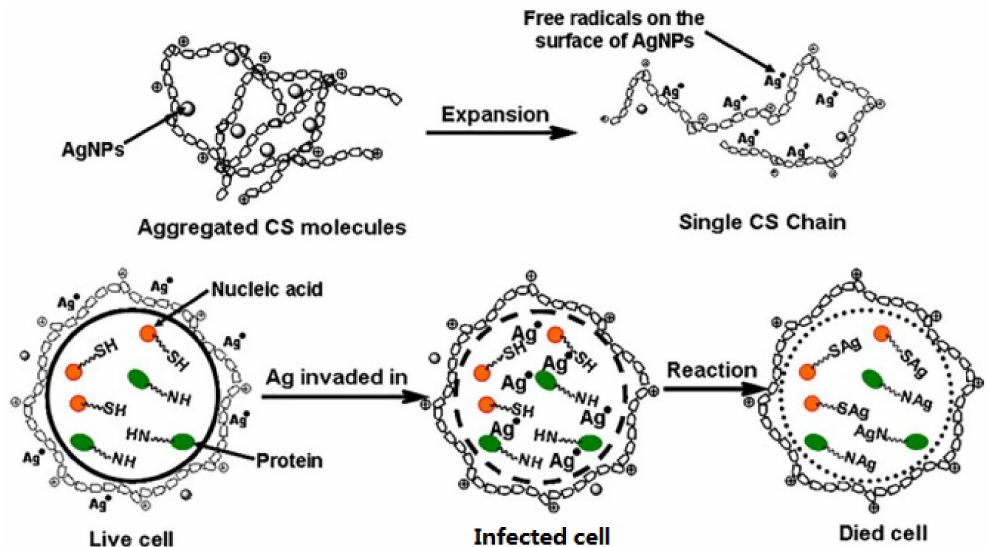
Figure 4. Schematic illustration of inhibition mechanism of AgNP/CS microspheres on microorganisms [22]. Many NH3+ groups exist on molecular chains of CS in acid solution, so these CS molecules usually aggregate due to the interaction between NH 3+ and -OH with partial electronegativity. AgNPs disperse uniformly in CS matrix combined with CS molecules by Ag-O bond in CAgMs. Strong interactions between AgNPs and -OH on CS molecules leads to decreased interaction between -NH 3+ and -OH, which is favorable to dissociation of aggregated CS molecules and exposure of -NH 3+ . Therefore, more positive amino groups (-NH 3+ ) are able to electrostatically contact with negatively charged bacteria cells, accelerating the breakdown of their cytoplasmic